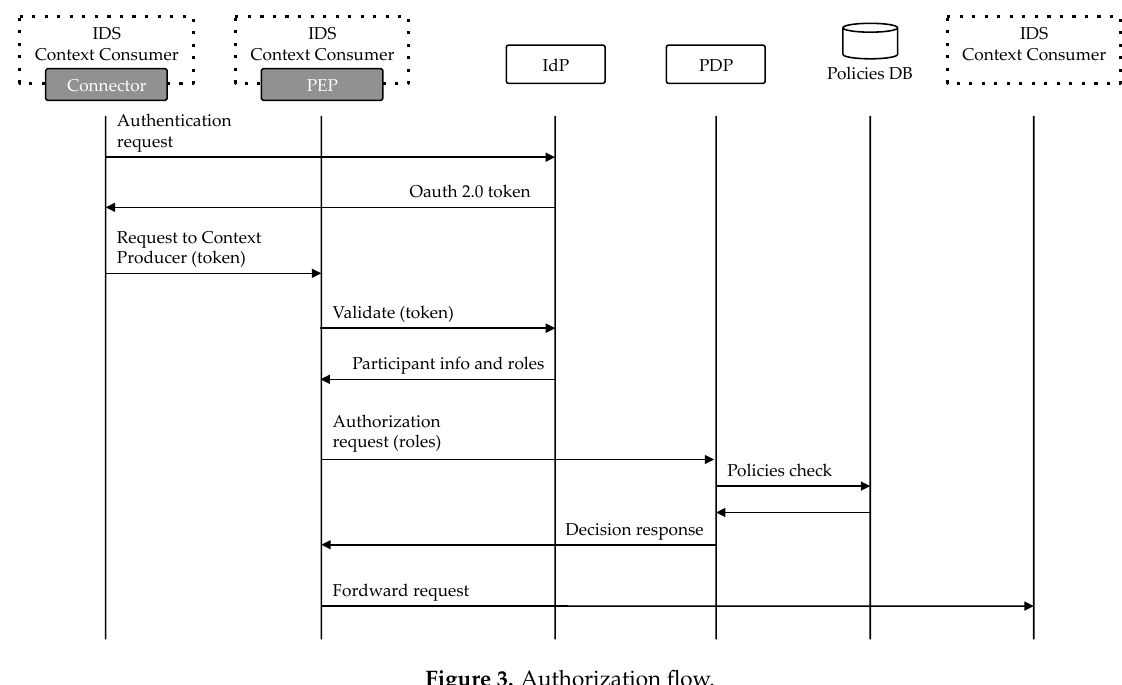
Figure 3. Authorization